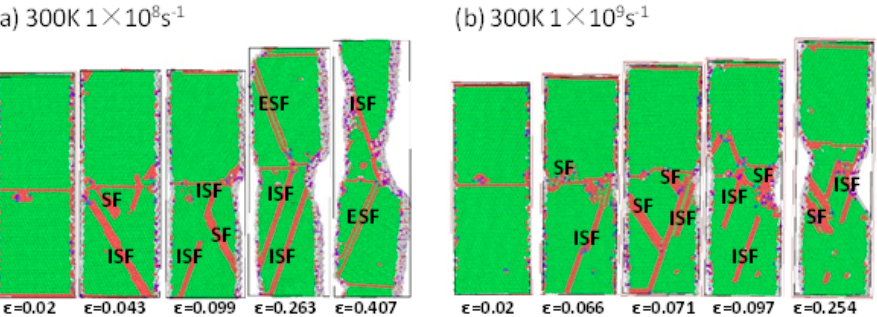
In order to research the morphology of crystal defects in plastic deformation of HEAs, the deformation mechanism of HEAs is analyzed by observing the atomic configuration diagram of high-entropy alloy by CNA diagram. The atomic structure diagrams with strain rates of 1 × 10 8 s − 1 and 1 × 10 9 s − 1 are selected, respectively, which was shown in Figure 6. Green is the fcc crystal structure, and red is the hcp crystal structure. The single-layer hcp structure is twinned (TB). Two adjacent hcp are intrinsic lamination (ISF), multiple hcp connected together are stacking fault (SF), and one layer between two hcp layers represents extrinsic lamination (ESF) [15].